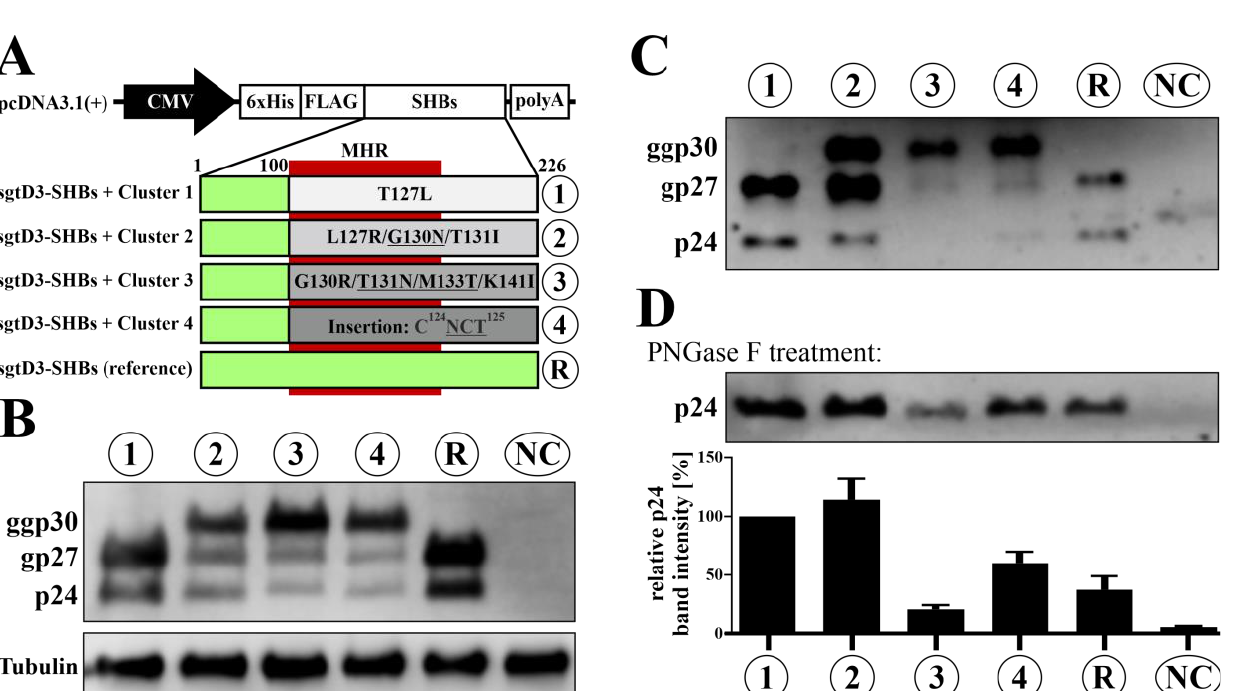
Figure 2. Ectopic sequons of the variant SHBs serve as N-glycosylation acceptor sites and cause hyperglycosylation of SHBs. ( A ) Construction of SHBs expression plasmids. Expression of N-terminally 6xHis- and FLAG-tagged SHBs is controlled by the CMV immediate/early promoter present in pcDNA3.1(+). The sequence encoding amino acids 100 – 226 (encompassing the MHR (aa100-163)) of the reference subgenotype (sgt) D3 strain was exchanged with the corresponding sequences of the viral variants. Mutations causing additional glycosylation are underlined. Representative Western blot of ( B ) intracellular and ( C ) extracellular SHBs expression pattern. HepG2 cells were transiently transfected with 6xHis-FLAG-SHBs-expression plasmids. Four days post-transfection, supernatants were collected and cells were lysed. Cell lysates/supernatants were subjected to SDS-PAGE and blotted. Membranes were probed with an anti-FLAG antibody to visualize SHBs. ( D ) SHBs in the supernatants was treated with PNGase F and subjected to Western blot as described above. Bands of deglycosylated SHBs of three independent experiments were quantified with Image Studio Lite. MHR = major hydrophilic region; NC = negative control (empty pcDNA3.1(+) was transfected); R = reference strain of sgtD3.